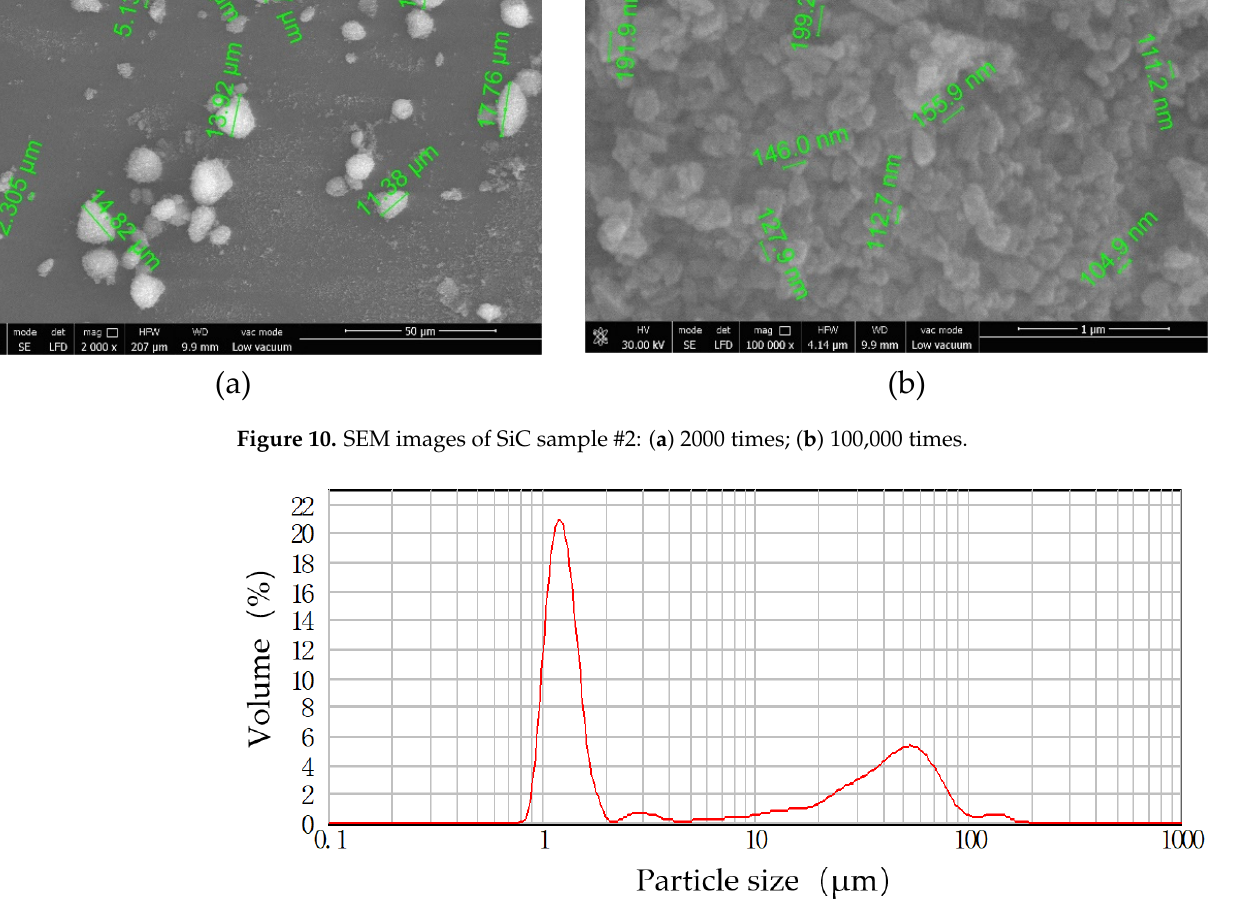
Figure 11. Particle size distribution of SiC sample #1.